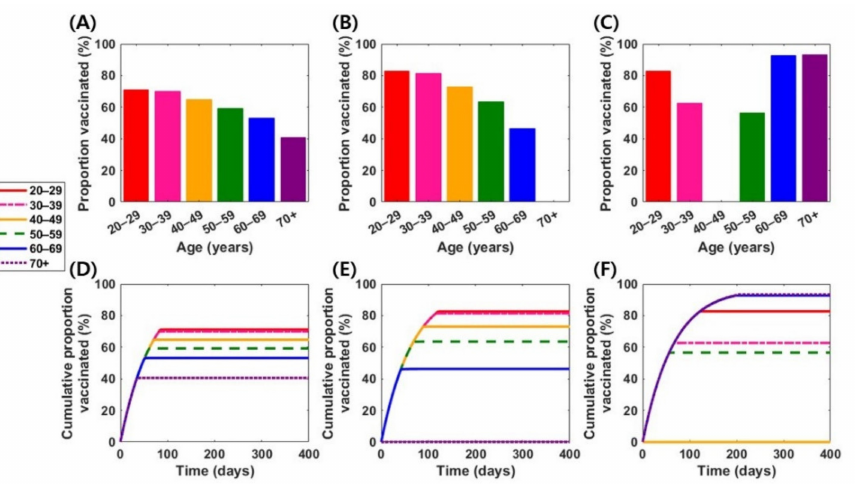
Figure 2. Optimal vaccination strategies in various vaccine scenarios. The first row represents age-specific levels of optimal vaccination coverage in the vaccine 1 ( A ), vaccine 2 ( B ), and vaccine 3 ( C ) scenarios. The second row represents time-dependent cumulative vaccination coverage levels under optimal vaccination schemes in the vaccine 1 ( D ), vaccine 2 ( E ), and vaccine 3 ( F )